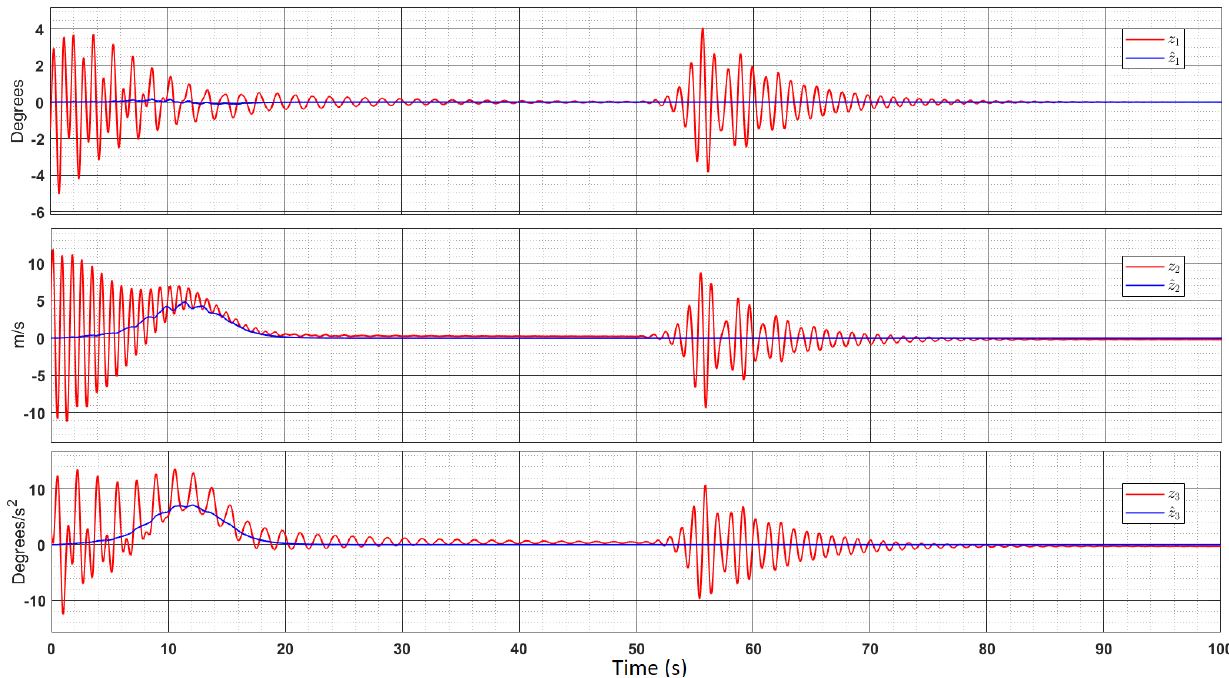
Figure 18. The reference and the nominal